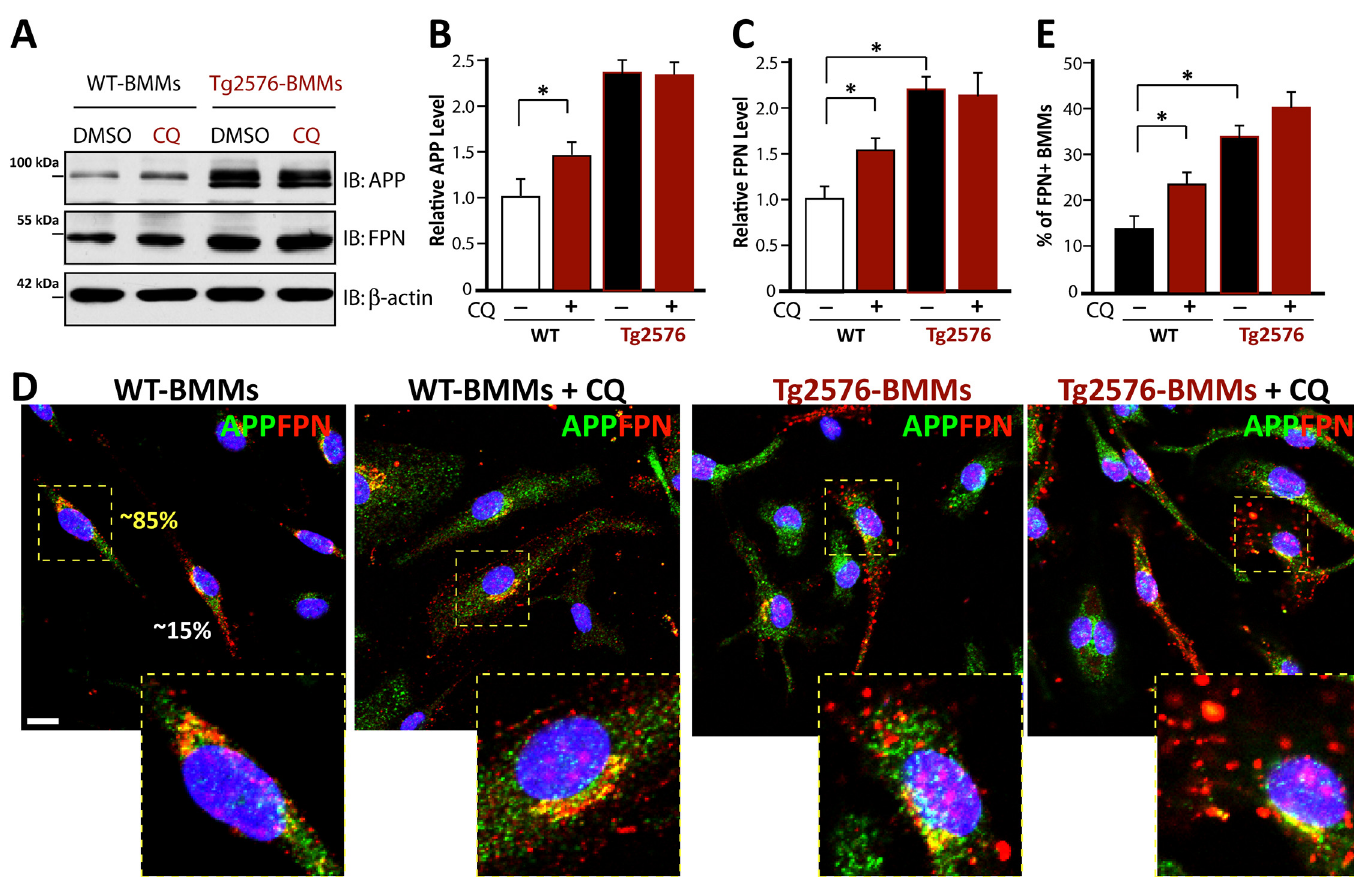
Fig 8. CQ regulation of APP and ferriportin (FPN) in BMMs. (A-C) Western blot analyses of WT- and Tg2576-BMMs treated with or without CQ (5 microM) using indicated antibodies. A, Representative blots. B, Quantification analysis of relative APP level (normalized by WT-BMMs, no CQ). C, Quantification analysis of relative FPN level (normalized by WT-BMMs, no CQ). (D-E) Immunostaining analysis of WT- and Tg2576-BMMs treated with or without CQ (5 μ M) using indicated antibodies. D, Representative images. Inserts were amplified images. Scale bar, 10 mm. E, Quantification analysis. The % of BMMs with cell surface distributed FPN were presented. The values of mean ± SD from 3 separate assays were shown. * , P < 0.05, significant difference.